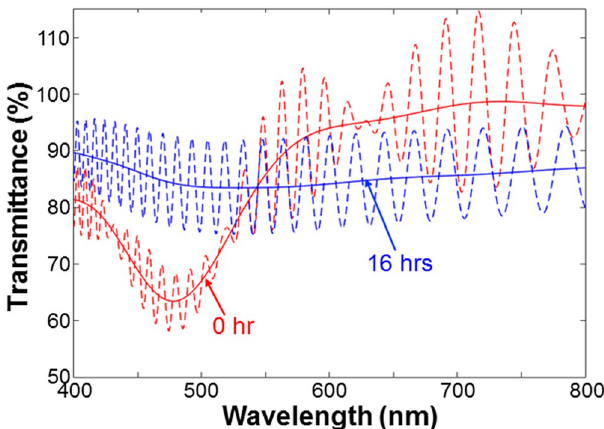
Figure 11. Transmission spectra of the Ag NP samples before (0 hr, red curves) and after 16-hour (16 hrs, blue curves) illumination shown in Figs 9(a) and 10(d), respectively. The oscillating dashed curve in each group represents the measured data with Fabry-Perot oscillation. The smooth curve is obtained by filtering the fast oscillation.